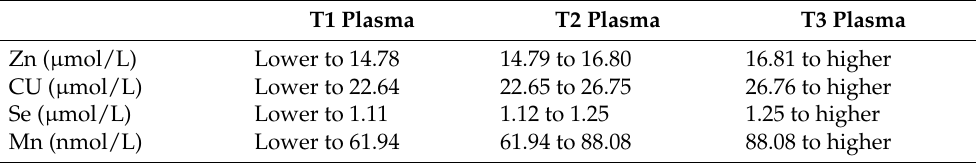
Table 5. Tertiles for plasma concentrations of Zn, Cu, Se, and Mn in the studied population.